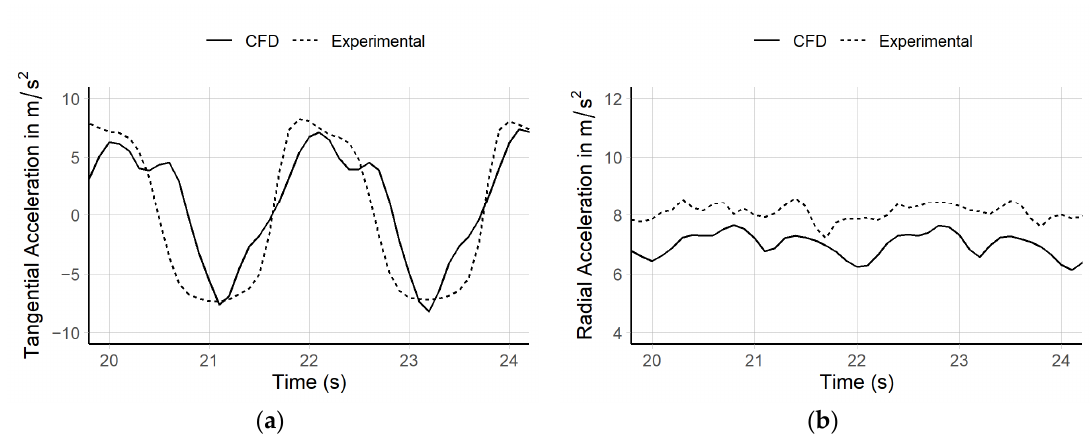
Figure 7. Tangential ( a ) and radial ( b ) accelerations of the numerical (Computational Fluid Dynamics (CFD)) and experimental values measured at the OWSC.